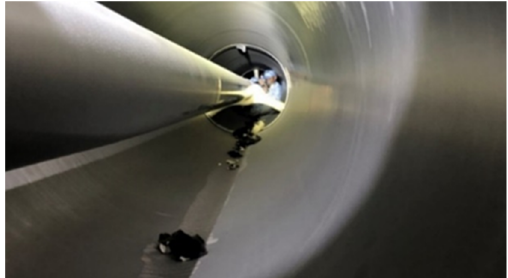
Figure 11. Inspection view of the fault location caused by flashover of a post insulator in GIL.